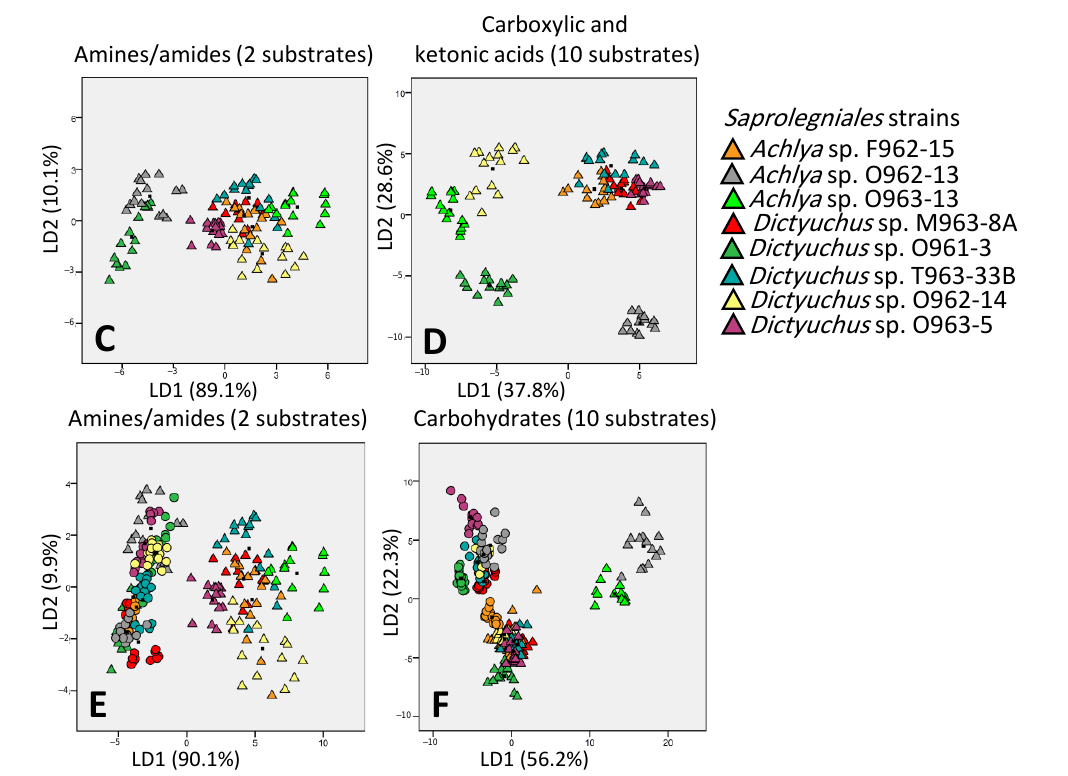
Figure 6. Discrimination ability of amides/amines (( A ) for fungal, ( C , E ) for Saprolegniales strains) and carbohydrates (( B ) for fungal, ( D , F ) for Saprolegniales strains) asthe worst and best discriminators, respectively. LD1 and LD2 show how many percentages of variance observed in the dataset are explained using linear dimension 1 and linear dimension 2. FB7Cladosporiumsp. FB11 Cladosporiumsp. FBPD2Cladosporiumsp. FB12 Cladosporiumsp. FBL81Cladosporium.sp. FBP8 Cladosporium sp.